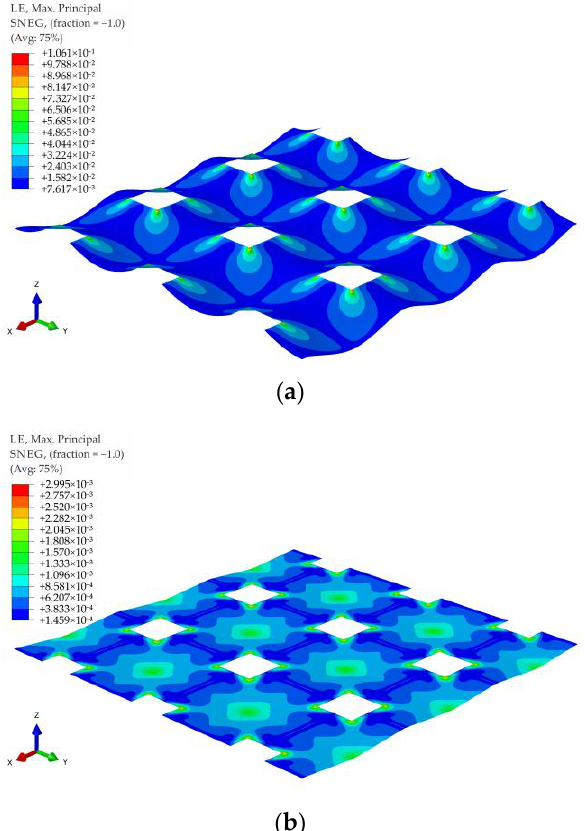
Figure 27. Deformation and maximum principal strain in reinforcement for pyramid shape load distribution, variant A1: ( a ) k = 0 kN/m 3 ; ( b ) k = 500 kN/m 3 .